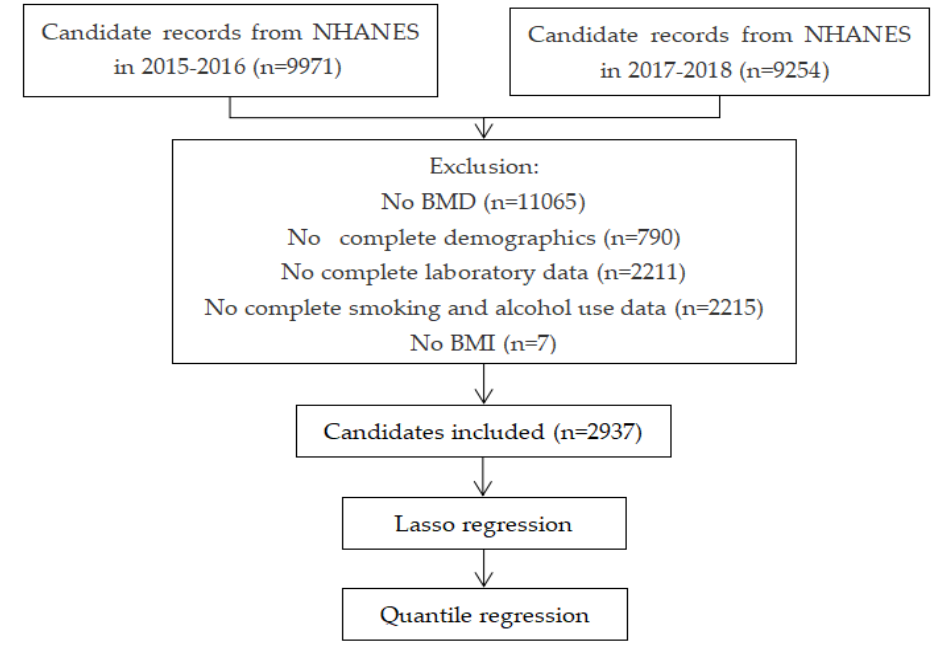
Figure 1. Flow diagram of the study in NHANES 2015–2018.